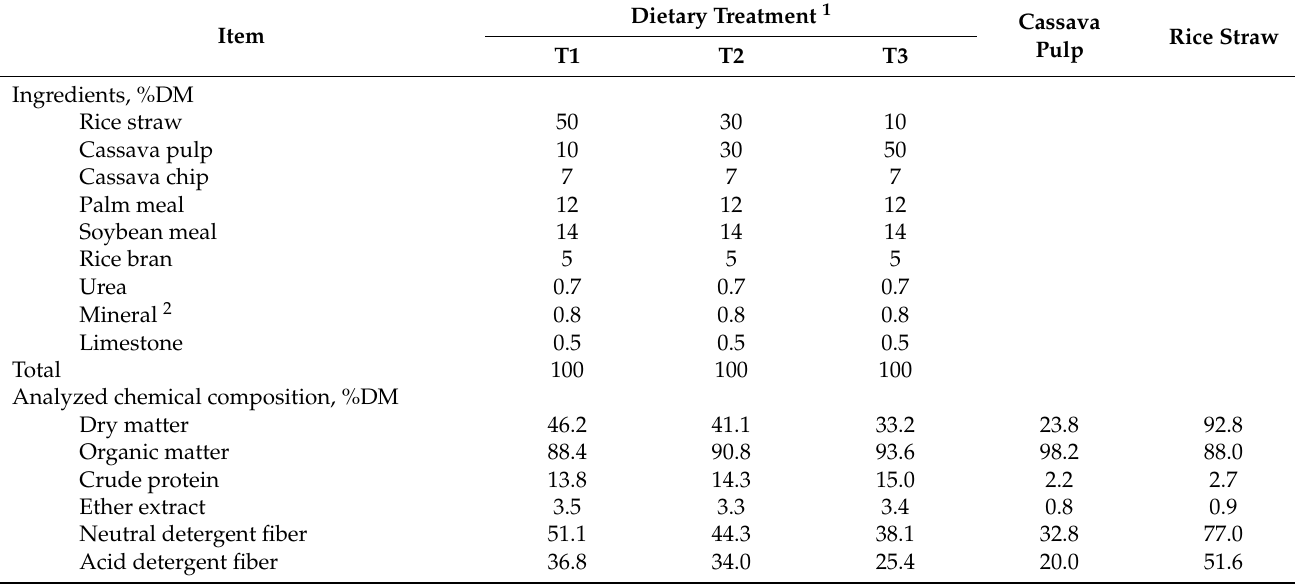
Table 1. Ingredients and chemical composition of dietary-energy-density treatment in native Thai cattle diet